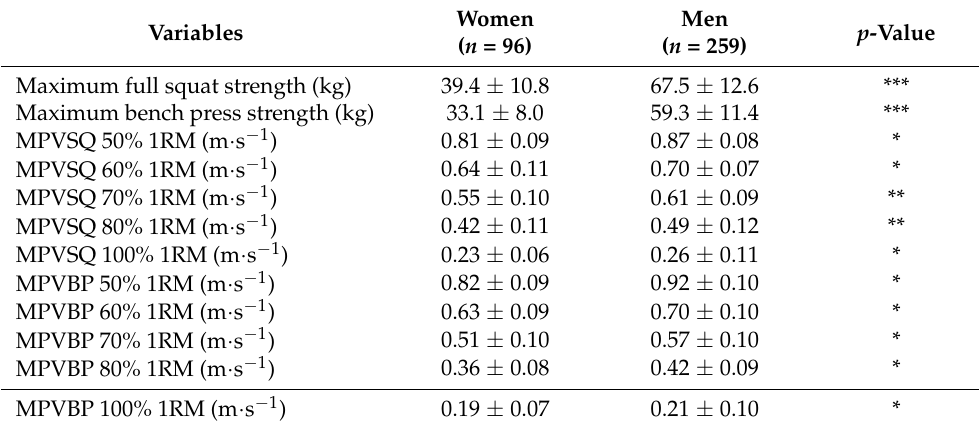
Table 1. Maximum strength and MPV values (mean and SD) in the full squat and bench press of the 352 participants.